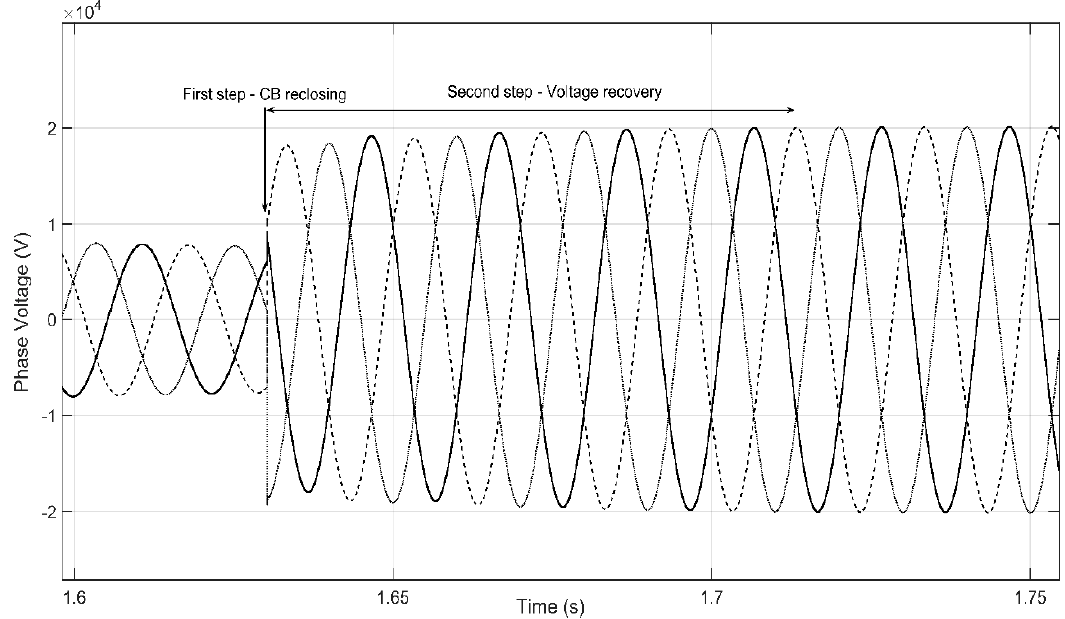
Figure 10. Voltage sag duration for the four simulated reclosing times.